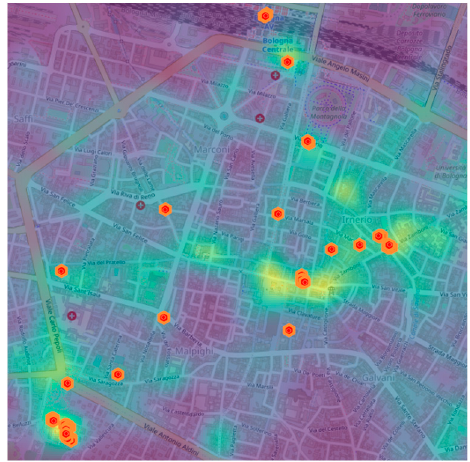
Figure 7. Graphical representation of location entropy for ParticipAct data set.